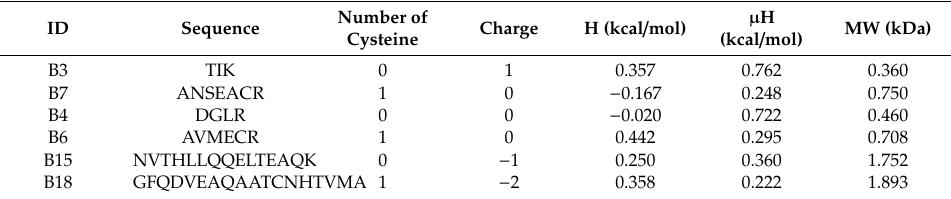
Table 1. Sequence information and characteristics of B49Mod1 predicted fragments.